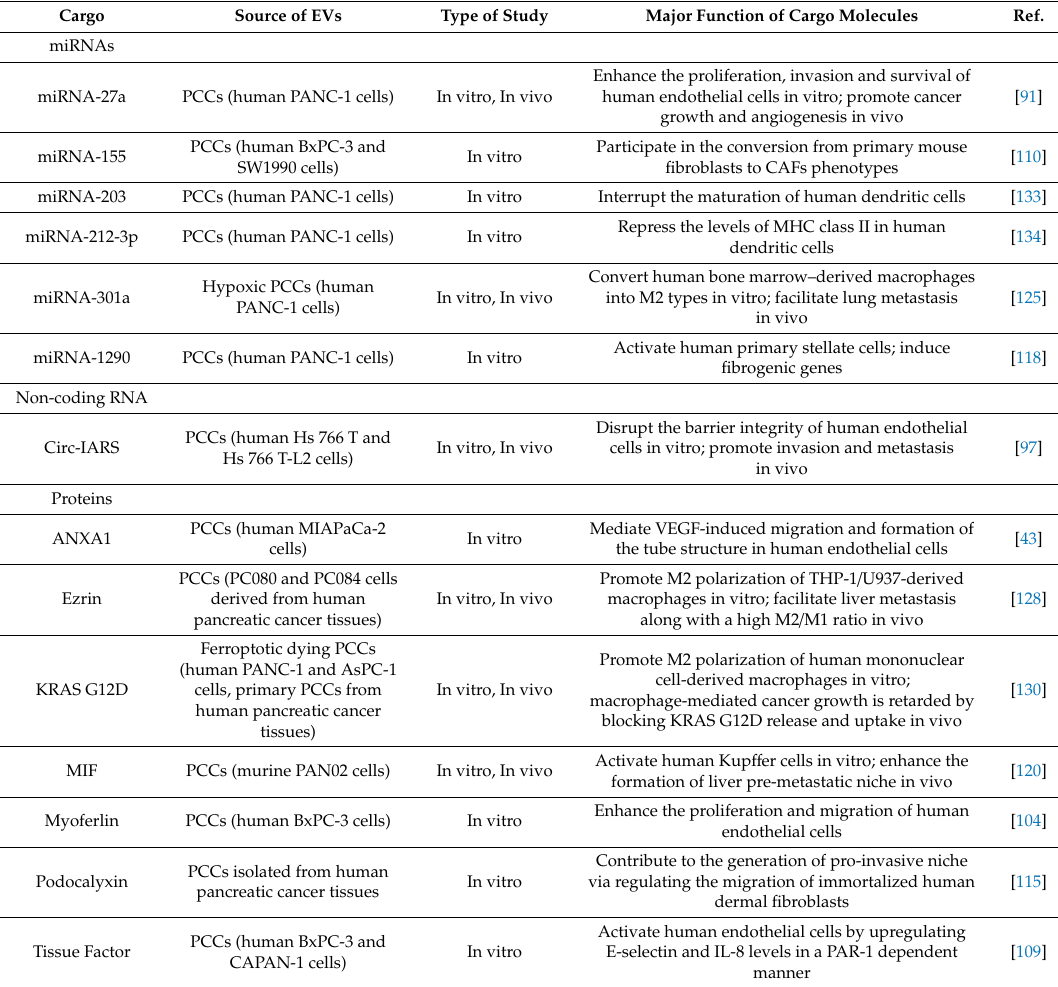
Table 2. Cargo molecules in PCC-derived EVs and their influences on the other cell types in cancer microenvironment and metastatic